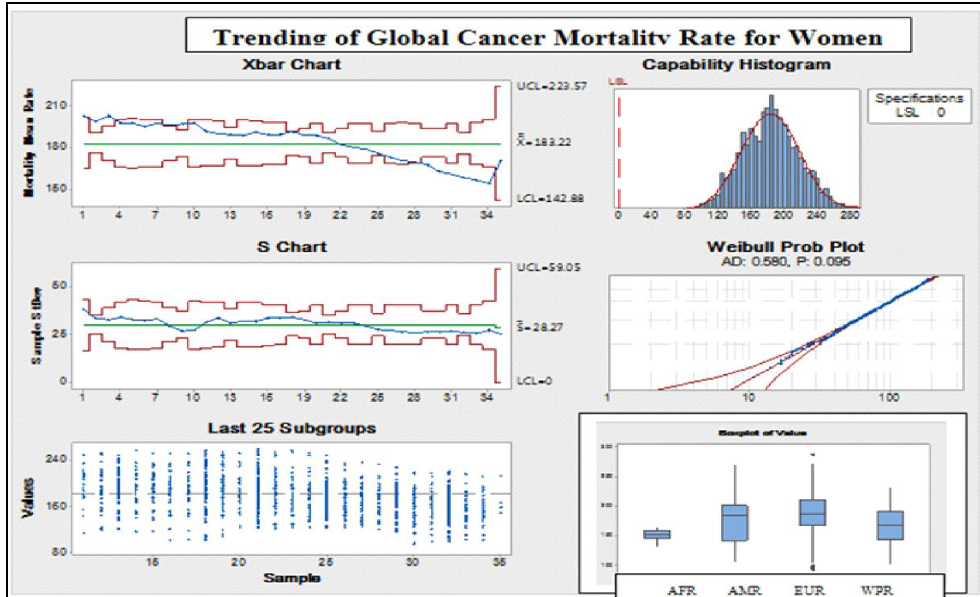
Figure 5 : SPC analysis tools, (control chart, histogram and box plot) of the global cancer mortality rates in women with Weibull probability fitting plot, showing the overall trend of the annual death rates as -S control chart and the pattern of WHO regions as box and whisker plot, generated using Minitab